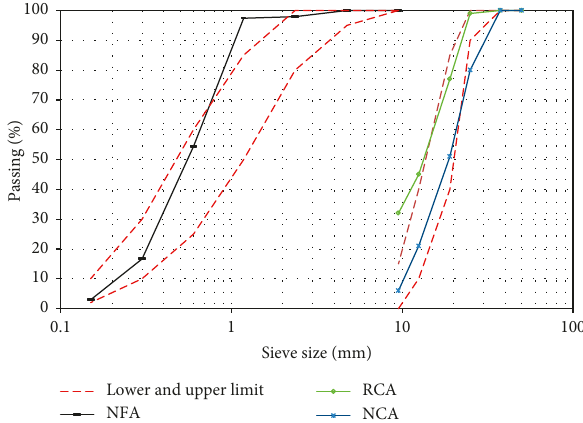
Figure 2: Grading chart of the fine aggregate, RCA, and NCA. Dashed lines indicate limits specified in ASTM C33/C33M.